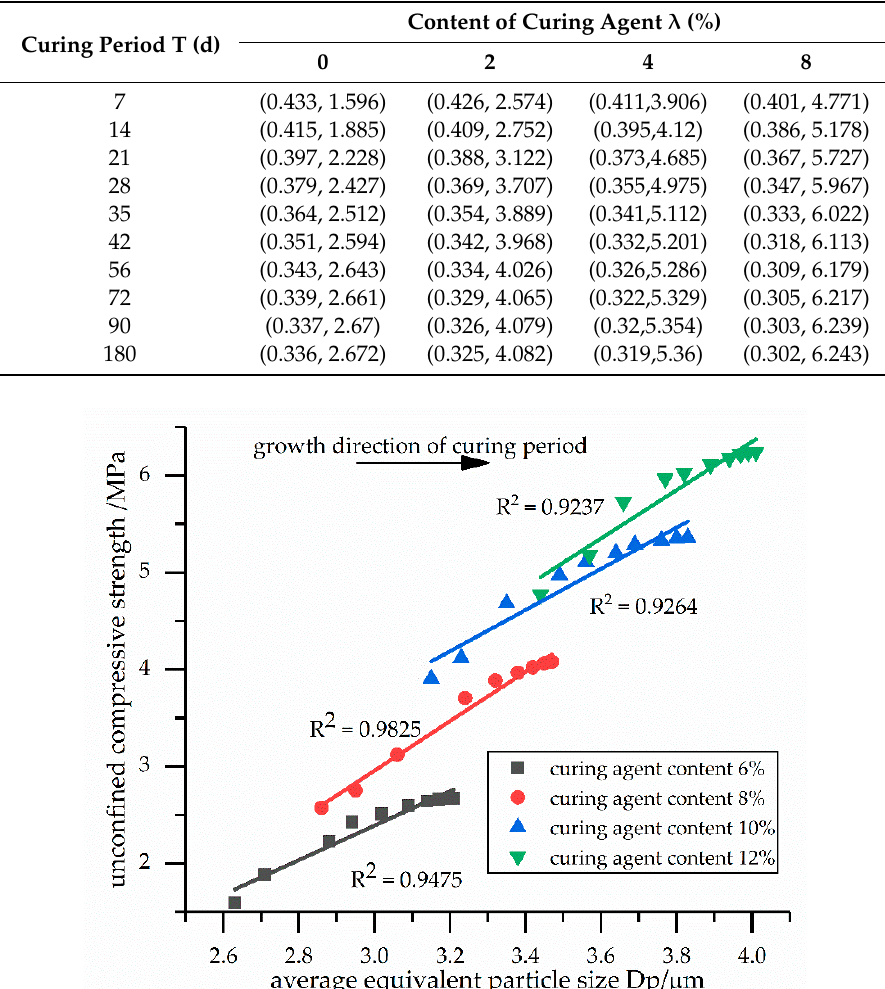
Table 9. The plane pore ratio ( x -axis) and the compressive strength ( y -axis).